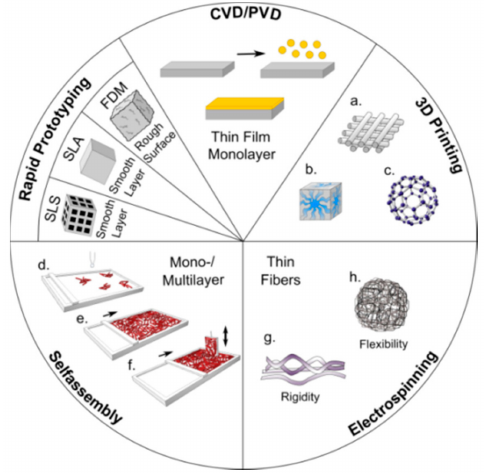
Figure 10. Fabrication methods used for the development of nanostructured scaffolds for tissue engineering applications: 3D printing, electrospinning, rapid prototyping and self-assembly techniques such as